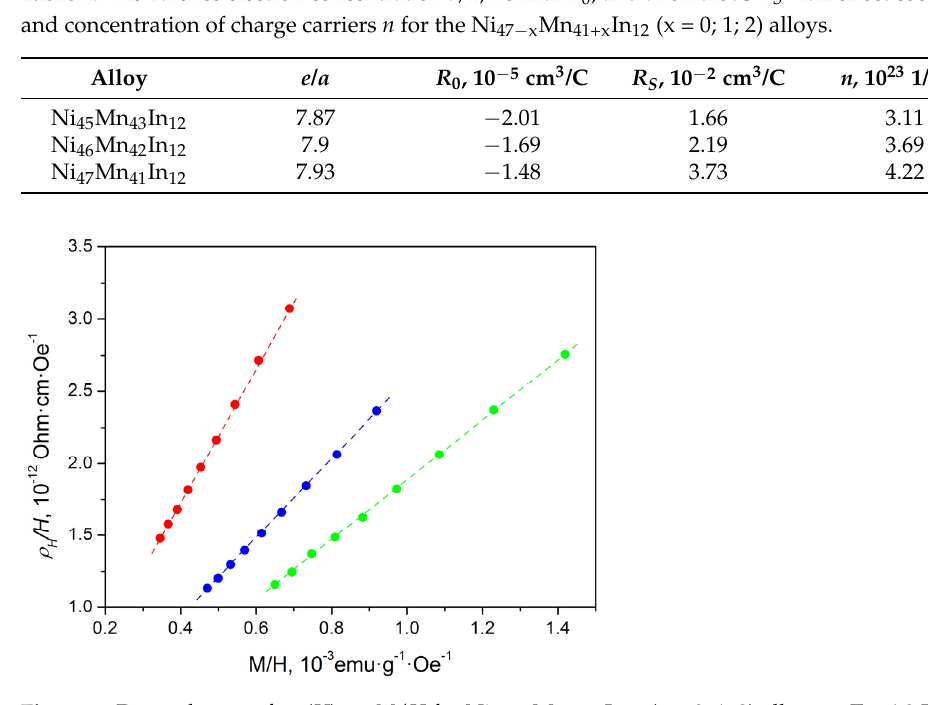
Figure 8. Dependences of the normal R 0 ( a ) and anomalous R S ( b ) Hall coefficients on the e / a ratio: green circle—Ni 45 Mn 43 In 12 , blue circle—Ni 46 Mn 42 In 12 , red circle—Ni 47 Mn 41 In 12 .